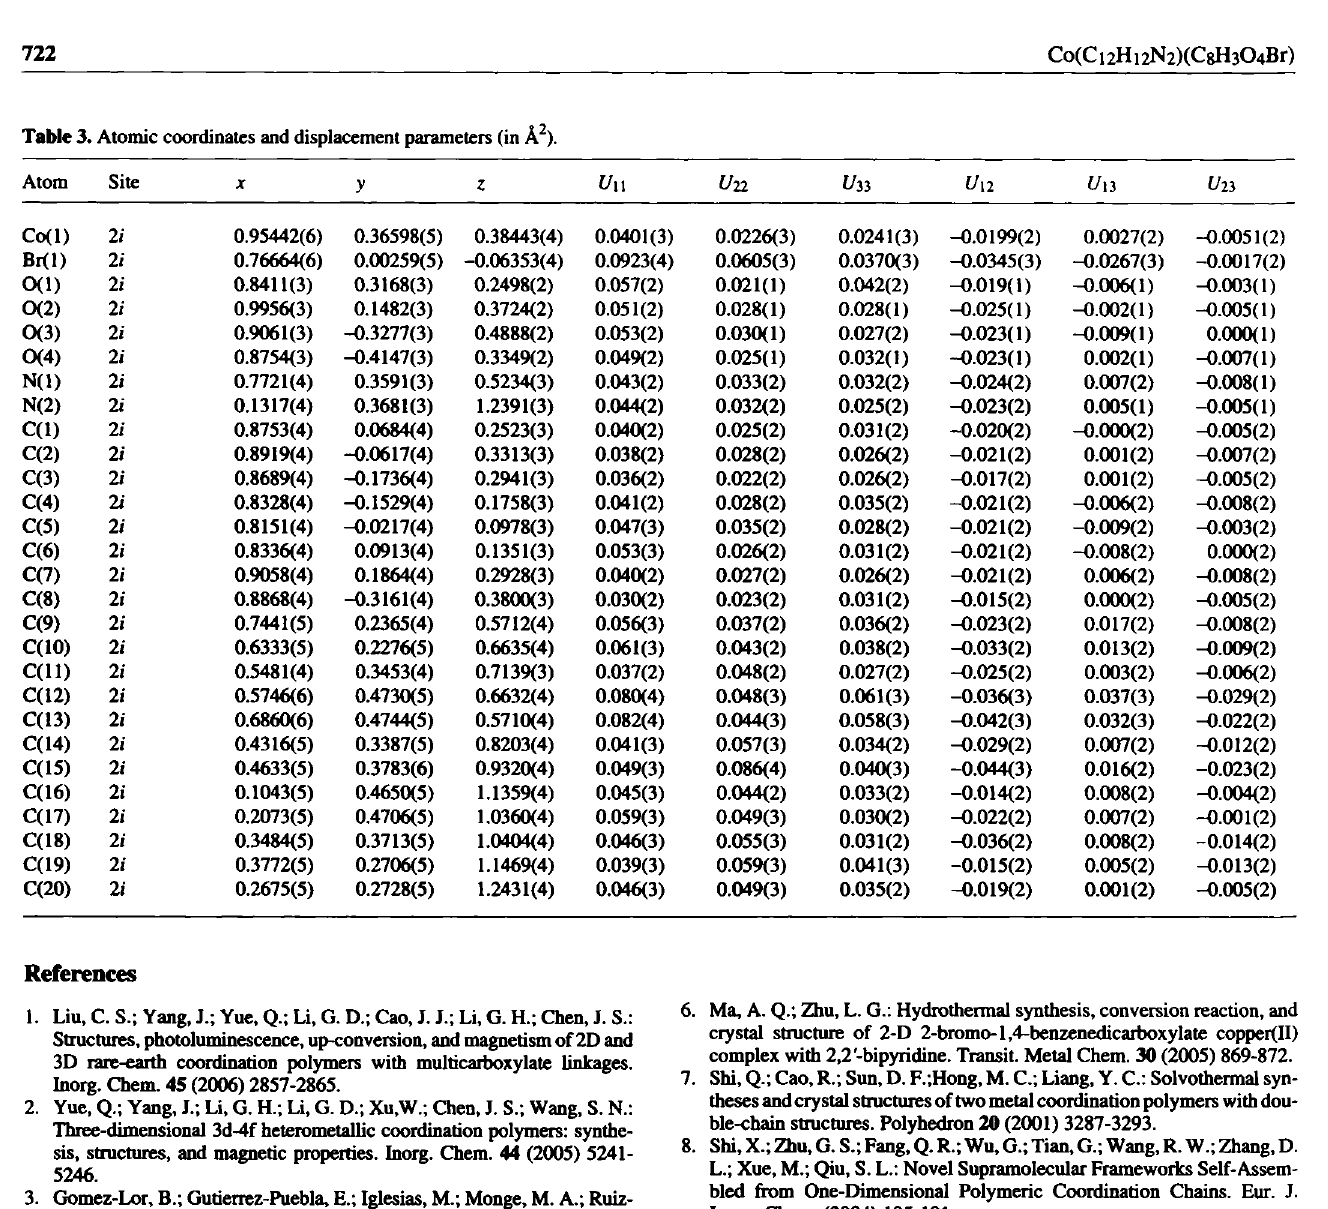
Table 3. Atomic coordinates and displacement parameters (in Â 2